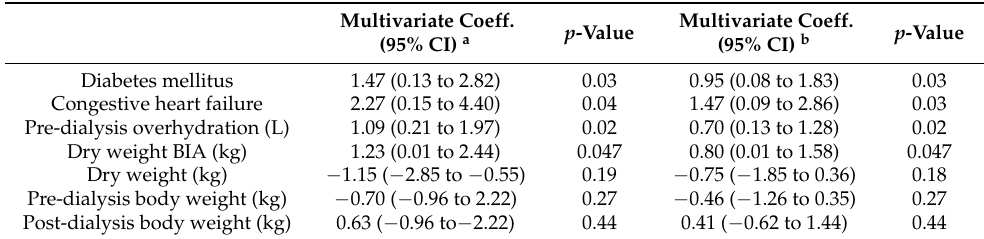
Table 4. The multiple correlation coefficient of the risk factors for unsuccessful reductions in hemodial- ysis frequency.